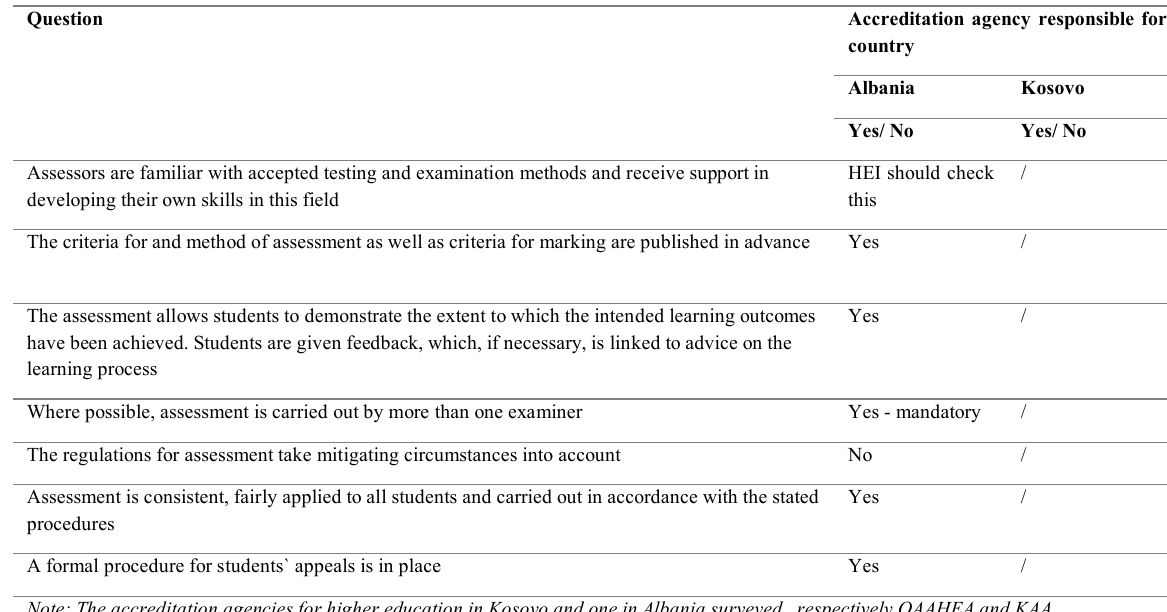
Table 14 : Internal quality assurance: Student admission, progresion, rcognition and ceritfication (KAA and QAAHE)